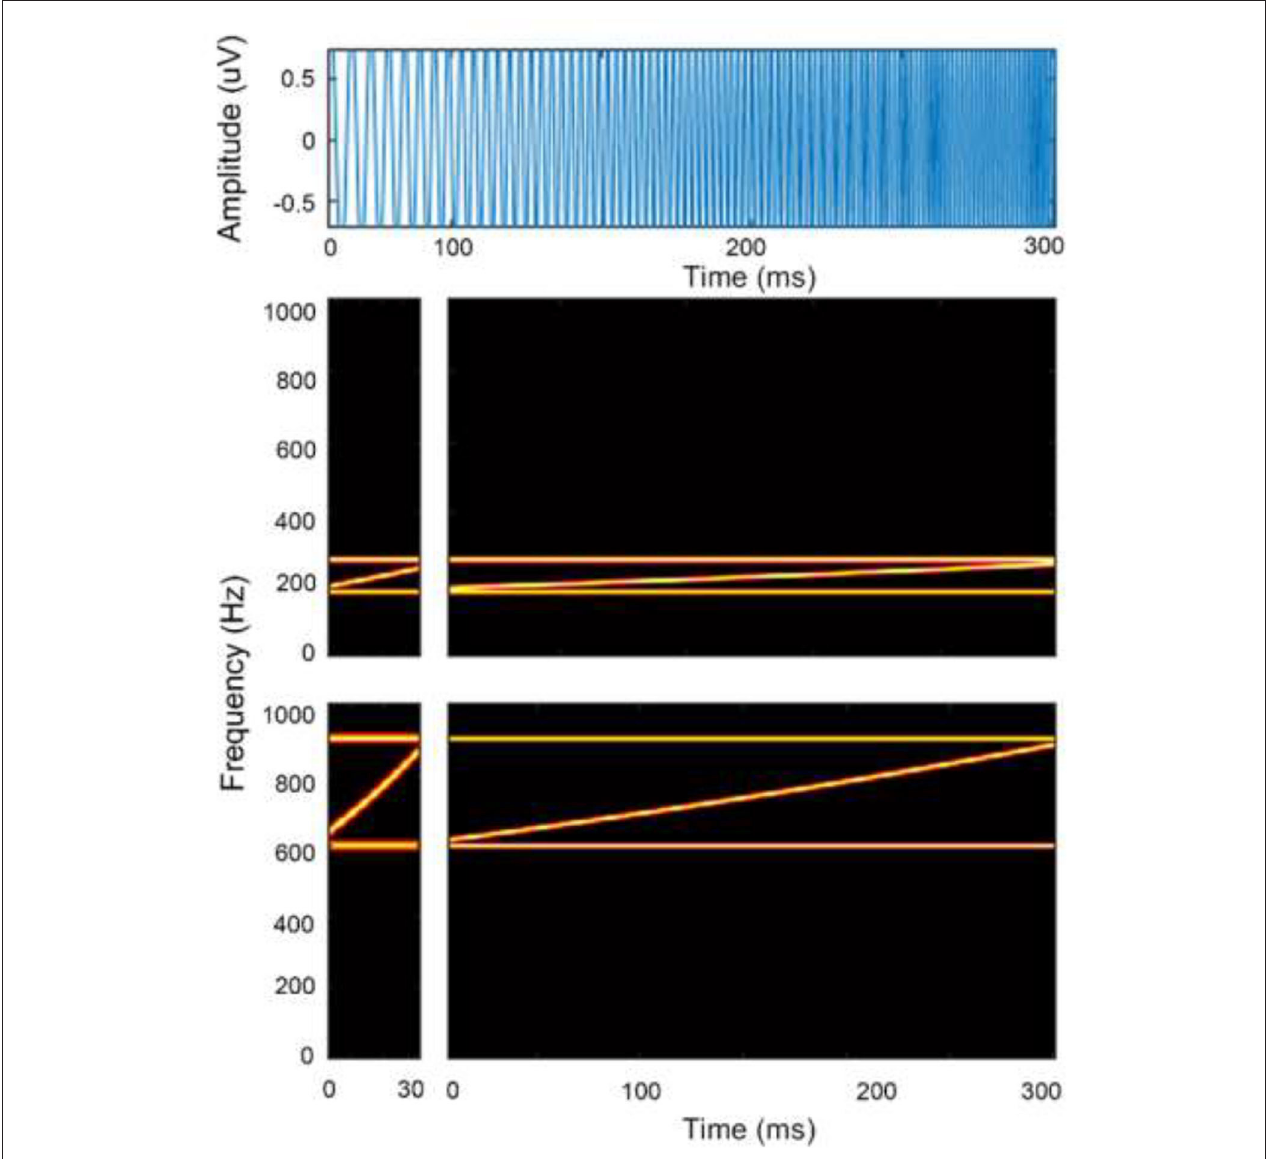
FIGURE 1 | Schematic diagram of the stimulus time waveform and spectrogram of a frequency sweep. Top panel shows time waveform in blue. Bottom panels show spectrograms of a rising frequency sweep contours in the F0 (top panels) and F1 frequency (bottom panels) region at local (left panels) and global timescale (right panels). Horizontal lines in red depict bounding